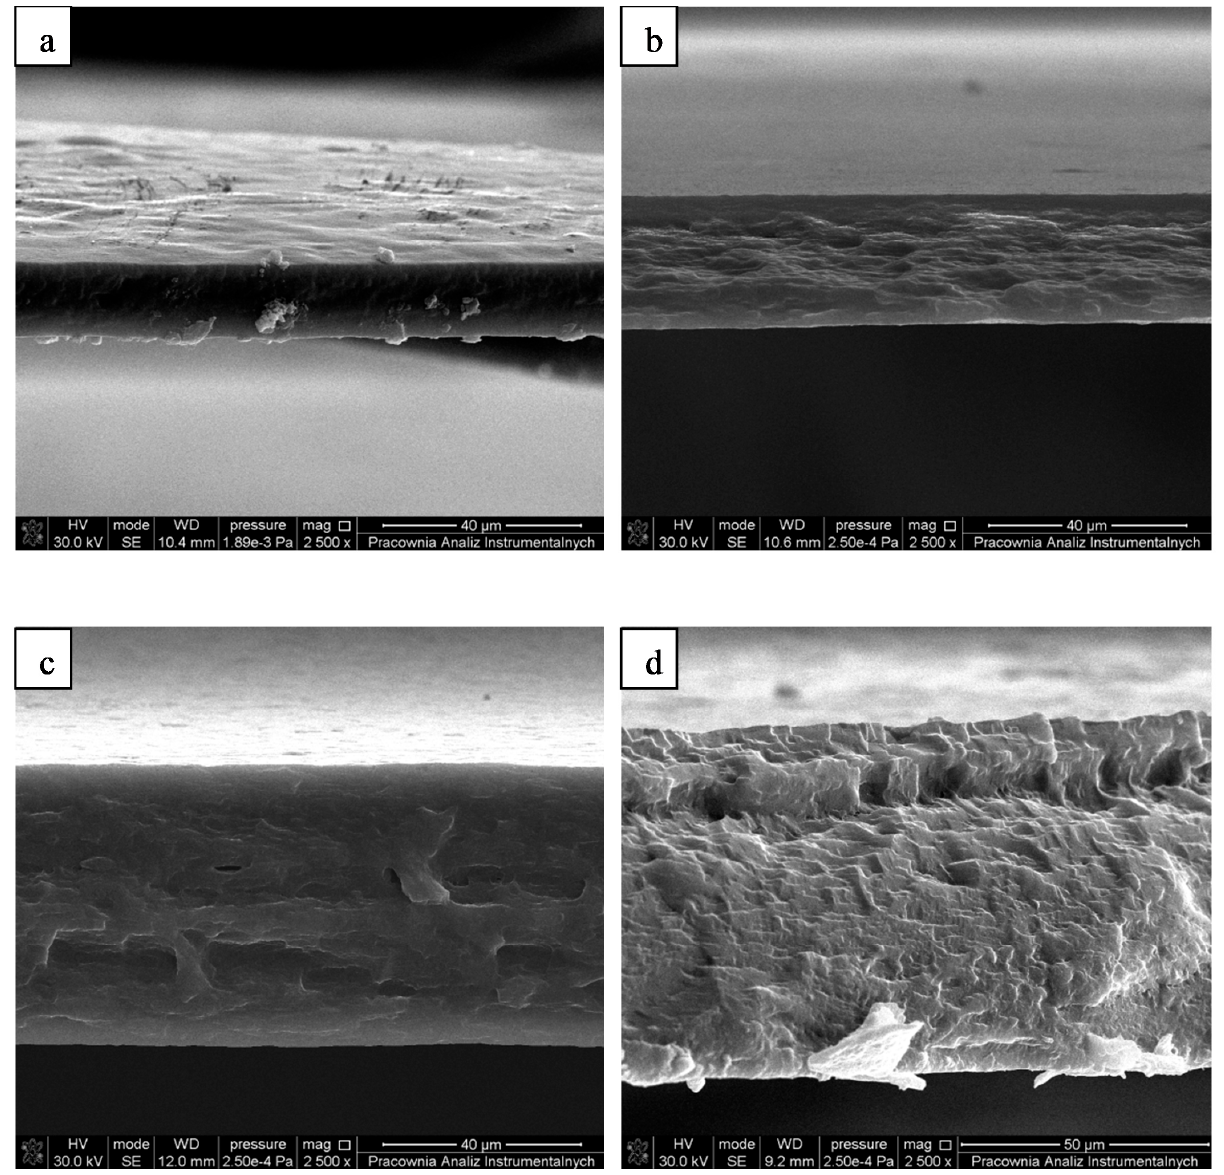
Figure 4. Scanning electron microscopy (SEM) images of materials’ cross-section: ( a ) Coll, ( b ) Coll90/10BG, ( c ) Coll70/30BG, ( d ) Coll50/50BG.